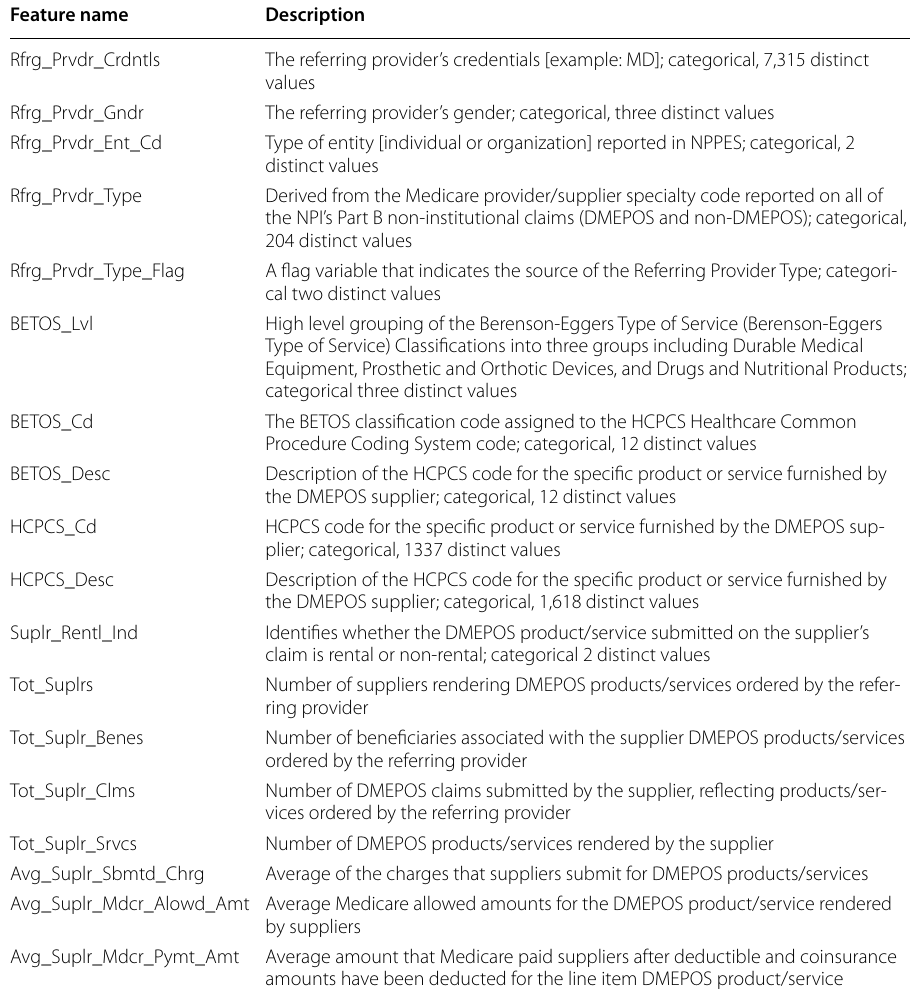
Table 1 Features of the DMEPOS